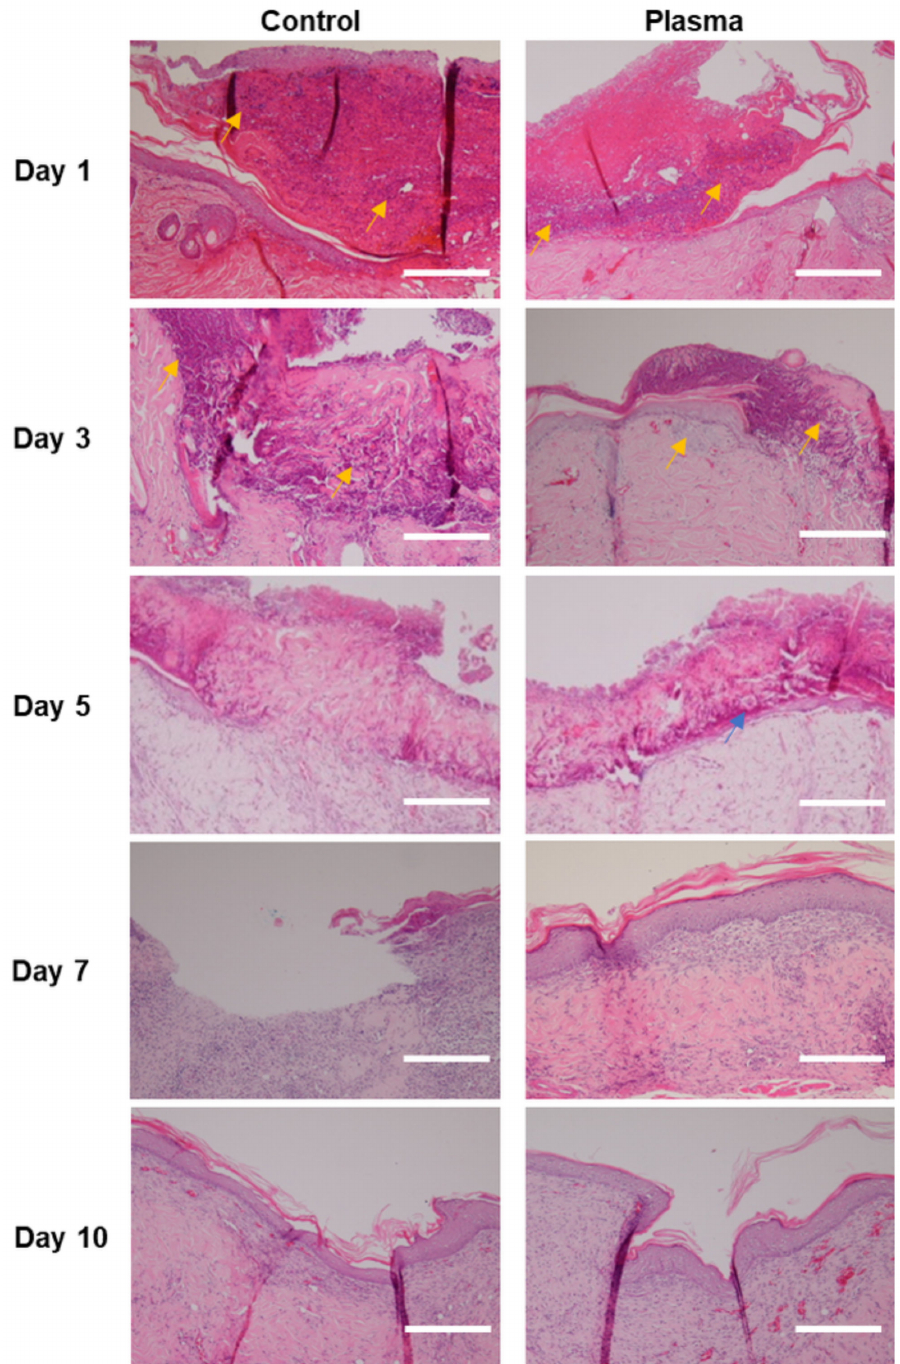
Figure 7. Representative histological images stained with hematoxylin and eosin of the skin wound of diabetic rat infected with C. albicans according to time. Faster tissue regeneration and less infiltration of inflammatory cells (yellow arrow) are noted in the plasma group compared to the control. Formation of keratin pearl was noted in the plasma-treated group at Day 5 (blue arrow). Epithelium as well as stroma are still damaged in the control group at Day 7, compared to the plasma-treated group, in which they are almost recovered. Original magnification × 20; scale bars = 250